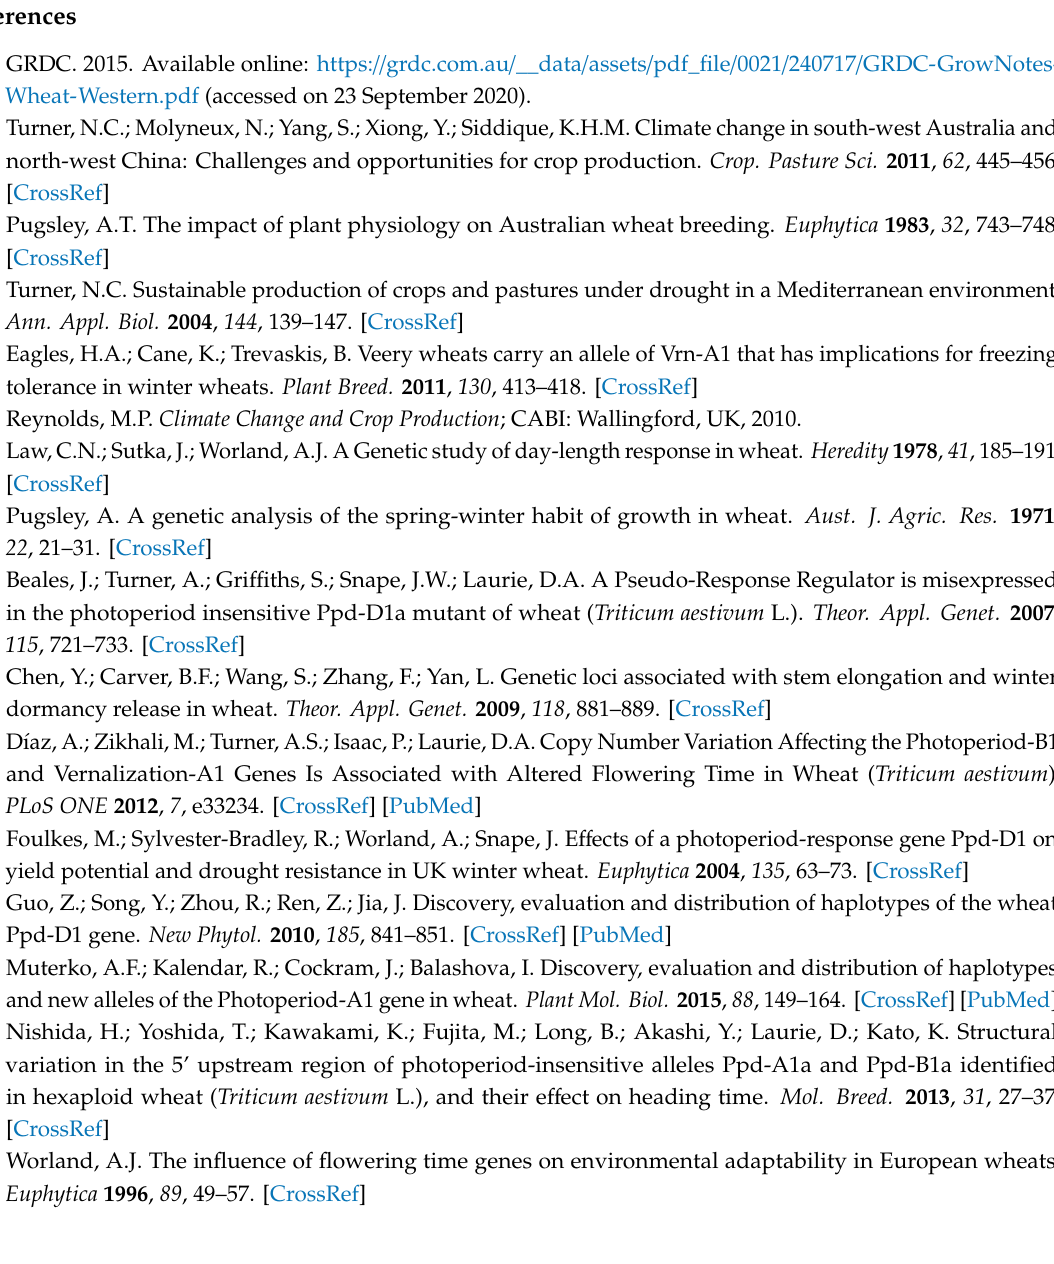
Figure S1: Frequency distribution for the identified alleles at di ff erent locus, Table S1: Environmental condition of the three trial sites during 2014 along with sowing and harvesting time, Table S2: REML variance components analysis for yield, Table S3: REML variance components analysis for protein content, Table S4: Stability parameters and environmental e ff ects on the advanced lines for